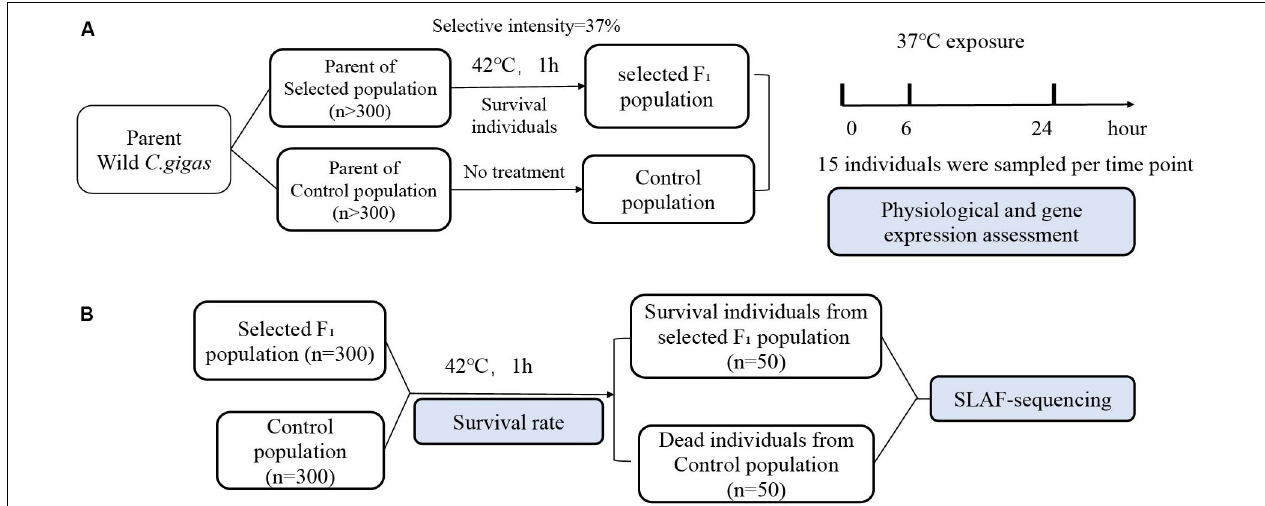
FIGURE 1 | Flow chart of the experiment. (A) Wild C. gigas was randomly divided into two population ( n > 300). One population was subjected to heat shock at 42 ◦ C for 1 h, and surviving individuals served as the parent of the next generation of selection for thermotolerance population, while the other population served as the control population without any treatment. The individuals from selected F 1 population and control population were exposed at 37 ◦ C seawater. Gills from 15 individuals were sampled at each time points of 0, 6, 24 h, which used to determine physiological parameters and gene expression. (B) After heat shock at 42 ◦ C for 1 h, selected F 1 population and control population were kept at ambient temperature restoration for 2-weeks recovery, and mortality was recorded. The gills of dead individuals from control population during the recovery period and that of the survival individuals from selected F 1 population after 2 weeks were sampled for SLAF-sequencing ( n =